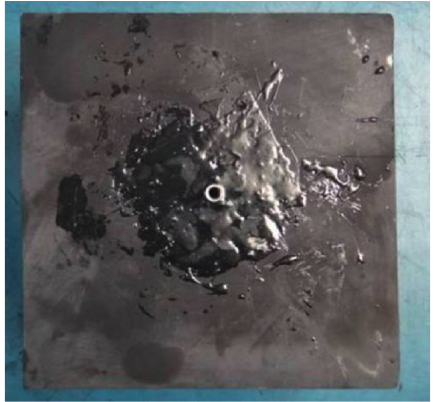
Figure 2: The shale specimen after processing.